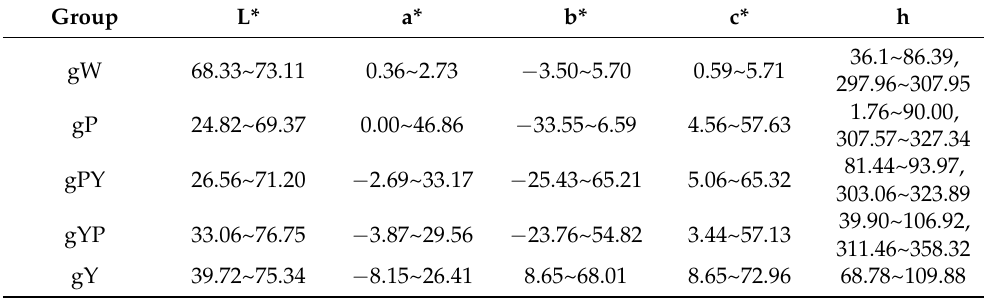
Table 1. The distribution range of CIELab colorimetric values (L*, a*, b*, c*, and h) for different Bletilla